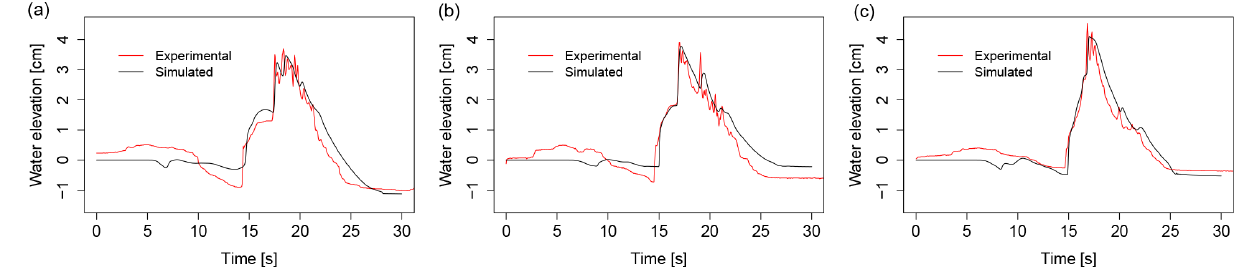
Figure A7. Simulated and experimental results for the laboratory-scale tsunami case at gauges G1 (a) , G2 (b) , and G3 (ca) .